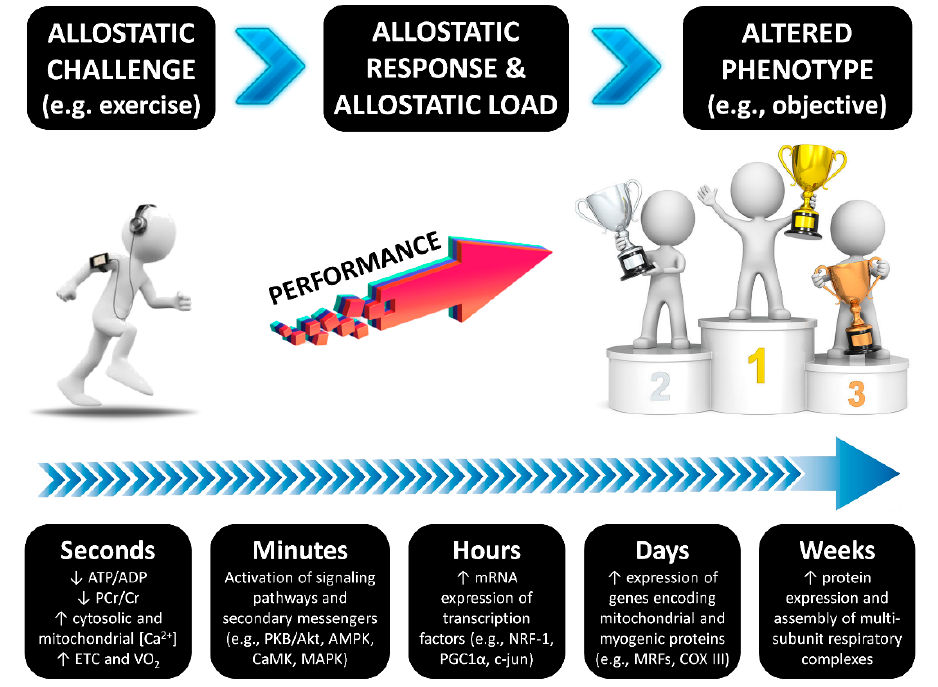
Figure 1. The time course of exercise-induced adaptations. Transient changes in metabolite sensing and signaling during/after exercise drive to gene transcription of early genes, myogenic regulators, genes of carbohydrate metabolism, lipid mobilization, transport and oxidation, mitochondrial metabolism and oxidative phosphorylation, and transcriptional regulators of gene expression and mitochondrial biogenesis [13]. DNA methylation is a regulatory point for transcription and may have a certain influence, although the current evidence suggest that exercise adaptations are regulated to a greater extent at the post-transcriptional level [14]. The time course changes following exercise have been described previously [15,16]. In this regard, the musculoskeletal tissue (as well as other tissues) possesses remark- able plasticity in response to repeated stimuli, such as exercise training, which results